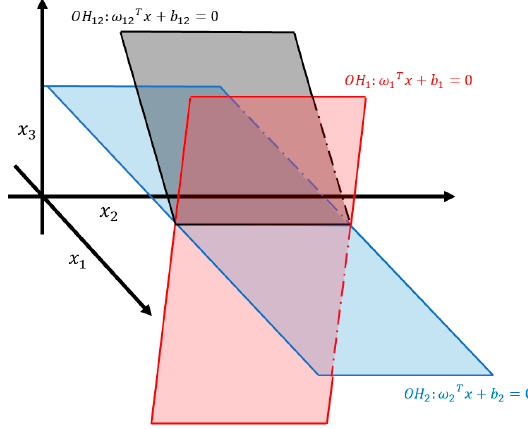
Figure 9. Schemes follow the same formatting.